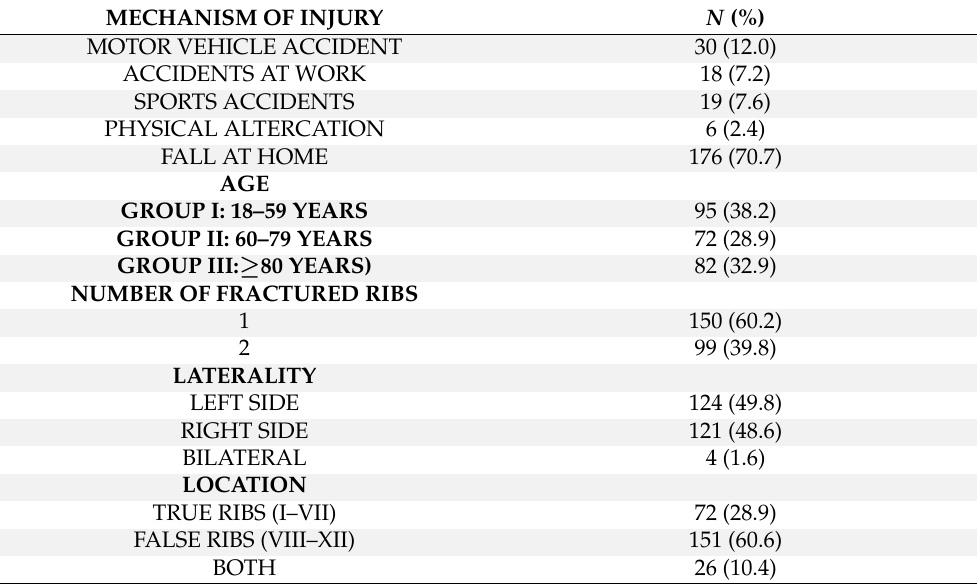
Table 1. Clinical characteristics of trauma patients with <3 rib fractures.